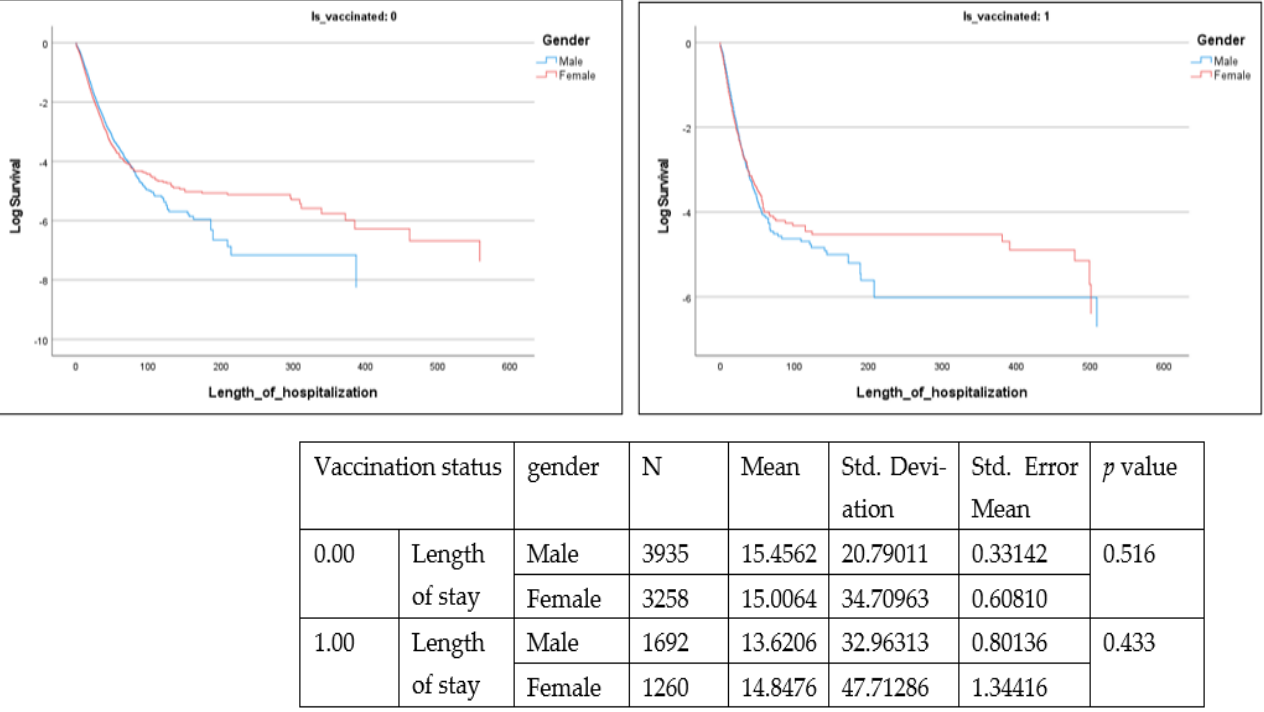
Figure 4. Length of stay (LOS) (Is_vaccinated 1 = vaccinated with at least one dose).